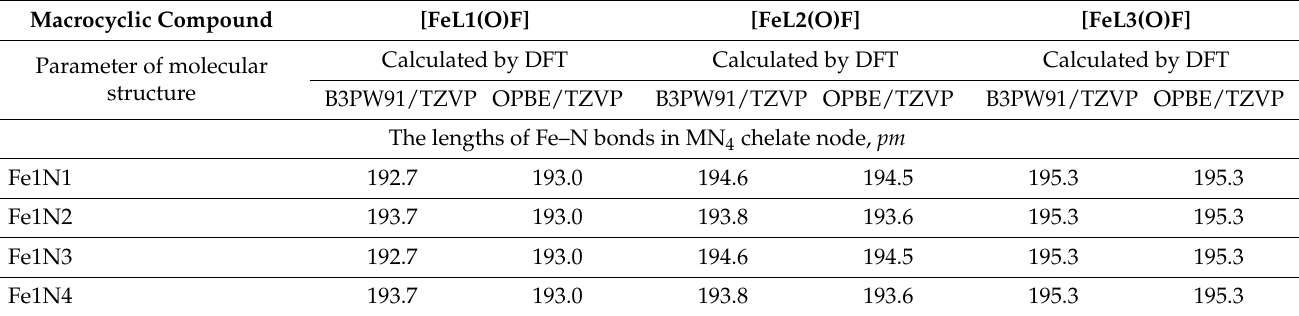
Table 1. Bond lengths and bond angles in the iron macrocyclic compounds [Fe L1 (O)F], [Fe L2 (O)F] and [Fe L3 (O)F] calculated by DFT B3PW91/TZVP and DFT OPBE/TZVP